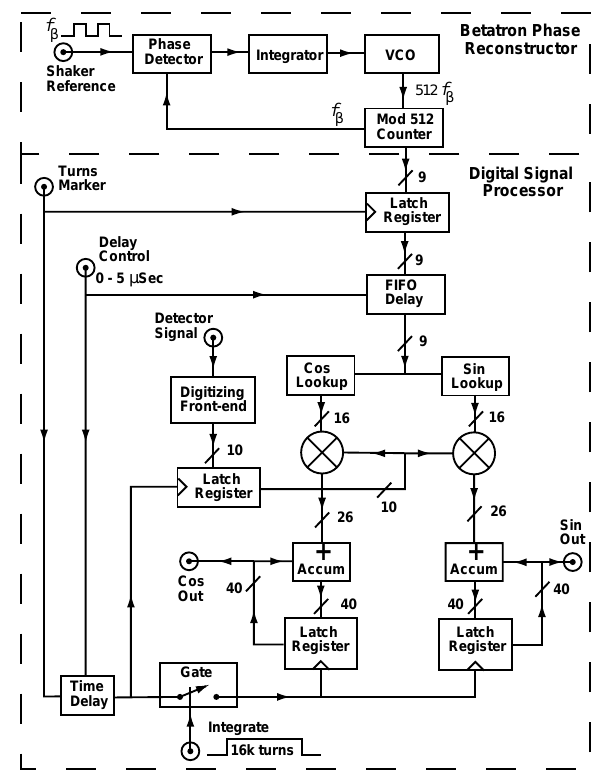
FIG. 2. Signal analyzer block diagram. Shown is the diagram for one normal mode (1 (cid:1) 2 of the signal analyzer). Not shown is the time multiplexing of the digital signal processor. The numbers beside the digital signal paths indicate the number of data bits. a clock for the digital generation of high-resolution sine and cosine functions for Fourier analysis. The phase- locked loop includes a modulo-512 counter which